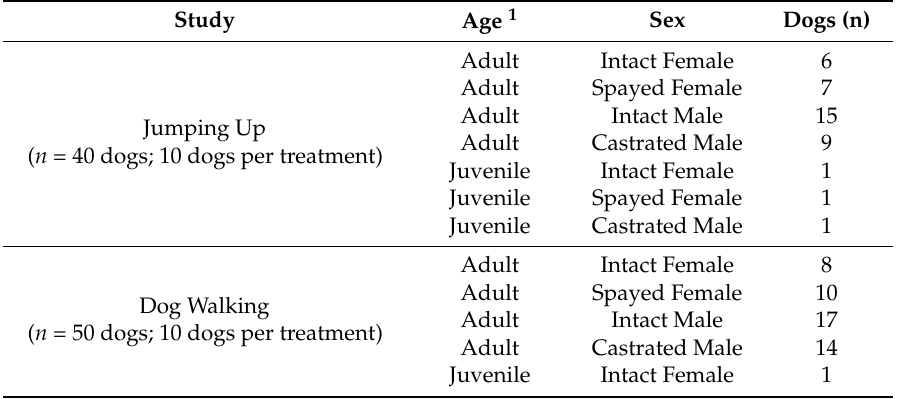
Table 1. Description of dogs used in the dog walking and leash pulling models.